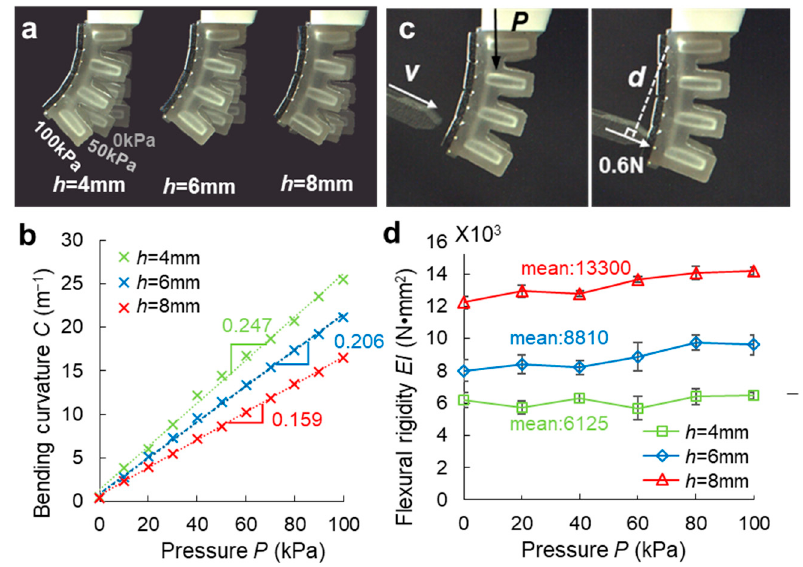
Figure 4. ( a ) The bending state of three SPAAs with rib heights of 4 mm, 6 mm, and 8 mm at 0 kPa, 50 kPa, and 100 kPa, respectively. ( b ) The experimental results of the bending curvature of three SPAAs with different rib heights under pressure drive. ( c ) The test flow of SPAA’s flexural rigidity. ( d ) The experimental results of the flexural rigidity of three SPAAs with different rib heights under pressure drive.